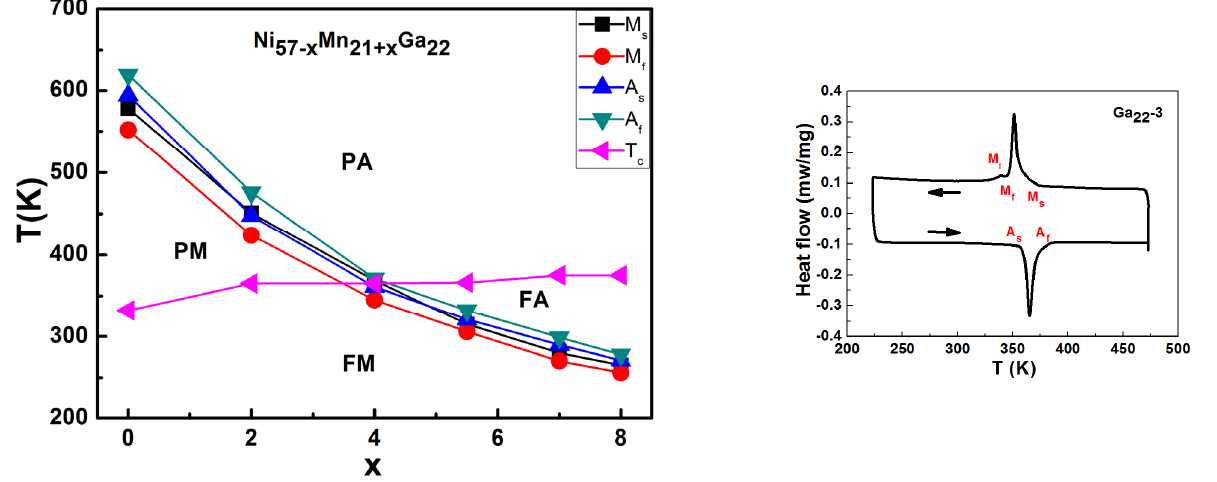
Figure 1. Composition dependence of phase transformation temperature and Curie temperature for the Ni 57 − x Mn 21+ x Ga 22 alloys, where A and M indicate the austenite and martensite, respectively. PA, PM, FA and FM denote paramagnetic austenite, paramagnetic martensite, ferromagnetic austenite and ferromagnetic martensite, respectively. T c , and M s , M f , A s , A f indicate the Curie temperature, and the martensitic and austenitic transformation start and finish temperatures. A panel of DSC curve to the Ga22-3 alloy is shown on the right of Figure